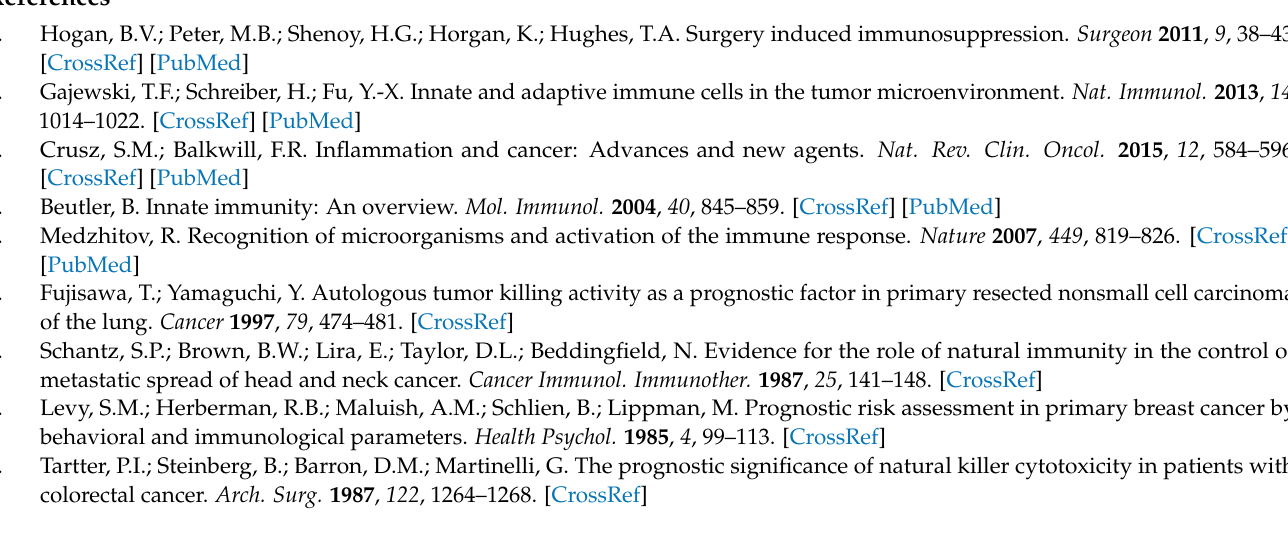
Figure A3. The cytokine levels in spleen cell supernatants. The cytokine levels were measured by CBA in the spleen cell supernatant after 24 h of incubation. The graphics show the cytokine concentrations in pg/mL. Values in ( a – c ) represent the median with interquartile ranges with n = 7–12 animals per group (SID + tumour: n = 9; laparotomy + tumour: 7; w/o op + tumour: 8; control: 12).